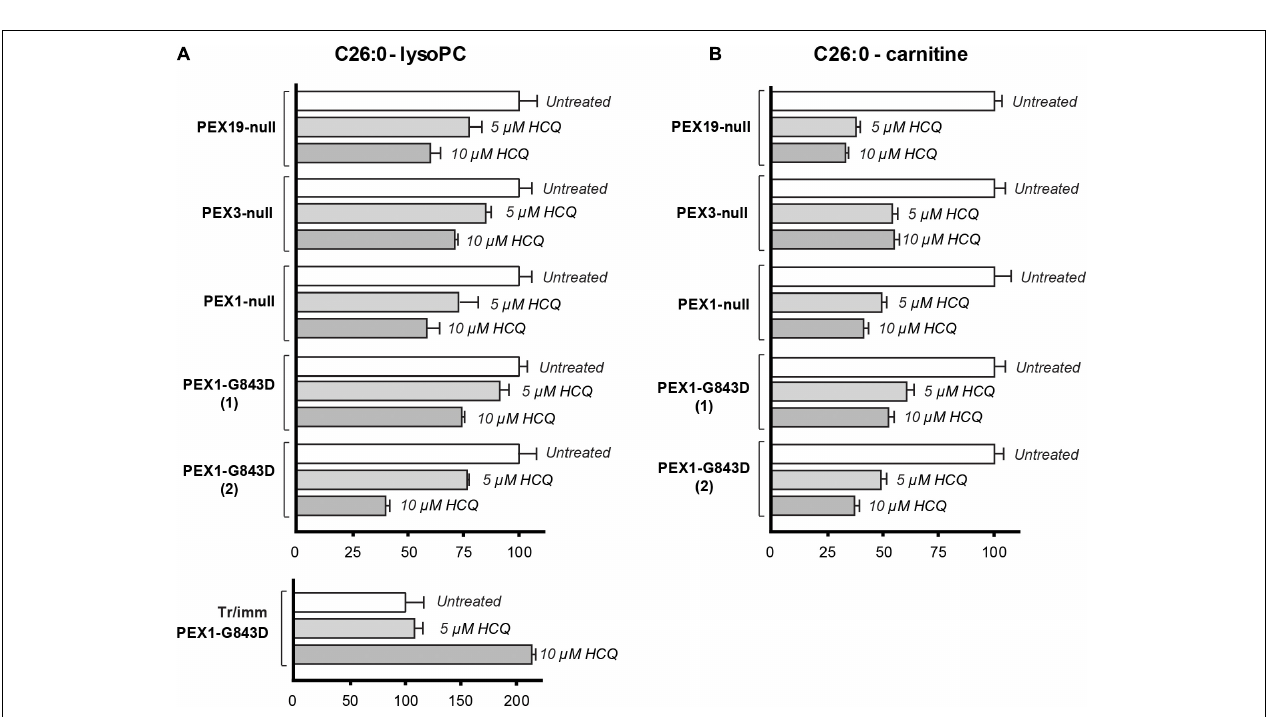
FIGURE 5 | Autophagy inhibitors do not restore import of peroxisomal matrix proteins in HEK 293 cells harboring the PEX1-G843D mutation. The effect of treatment with different compounds on peroxisomal matrix protein import was assessed in HEK 293 cells, which are functionally homozygous for PEX1-G843D introduced by Crispr-Cas9 genome editing. The HEK crPEX1-G843D cells were incubated with 20 mM L-arginine (L-arg), 2.5% glycerol (Gly) or 10 µ M hydroxychloroquine (HCQ) for 4 days. Since 3-MA incubation was found to be lethal for the HEK crPEX1-G843D cells, we excluded this treatment from the experiments. Wild-type HEK 293 cells (HEK WT) and Crispr-Cas9-generated HEK 293 cells with no functional PEX1 (crPEX1 − / − ) were used for reference. (A) Quantification of HEK crPEX1-G843D cells that display functional peroxisomal catalase import after treatment. Cells were analyzed by immunofluorescence microscopy to determine the subcellular localization of catalase ( > 300 cells analyzed for each condition). (B) Immunoblot analysis of homogenates of treated HEK crPEX1-G843D cells. The processing of thiolase was determined using specific antibodies. Below the thiolase bands, the corresponding ratios between the intensity of processed (41 kDa) over unprocessed (44 kDa) thiolase are indicated. To study the effect of different treatments on autophagy we determined the ratio of LC3-II over LC3-I. For this, we also treated cells with 5 µ M hydroxychloroquine and 10 µ M bafilomycine.